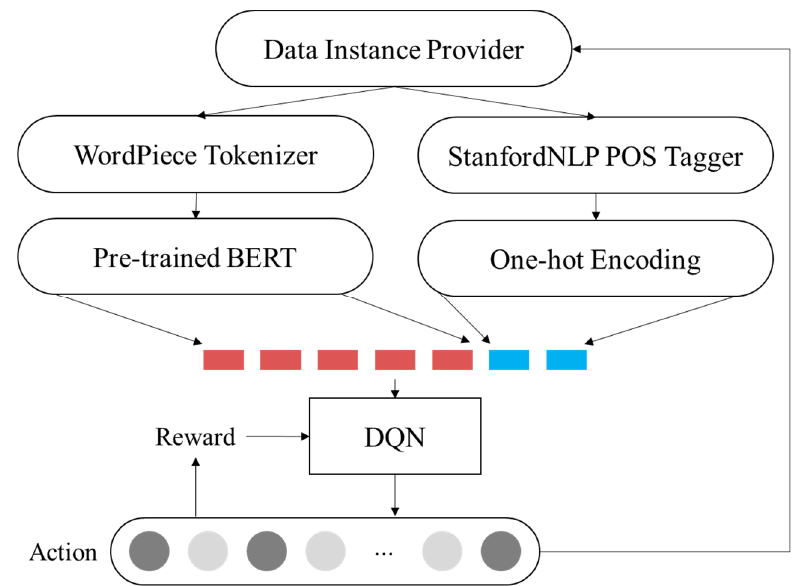
Figure 3. Architecture of DeNERT.